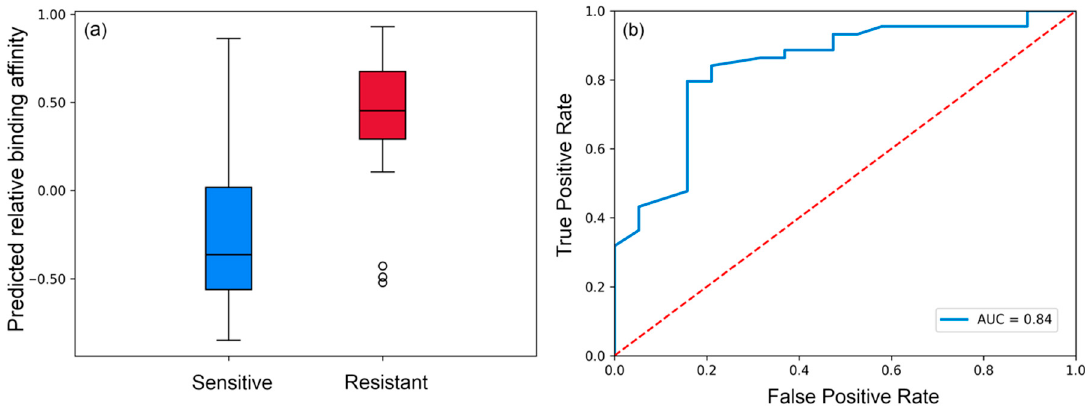
Figure 5. Statistics of predicted affinities of 45 sensitive and 19 resistant HIV-1 gp120 strains towards VRC01. ( a ) Distribution of the predicted binding affinities; ( b ) Receiver operator characteristic (ROC) curve achieving an area under the curve (AUC) of 0.84.